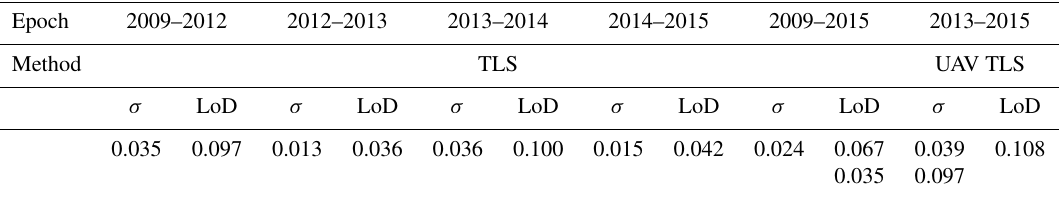
Table 3. Standard deviation and LoD (at a 95% confidence interval) in meters for the single TLS and UAV epochs derived on the basis of the stable